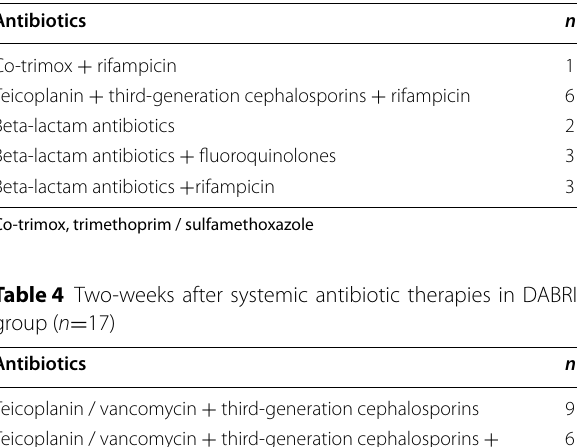
Table 1 Demographics and surgical details of 32 patients